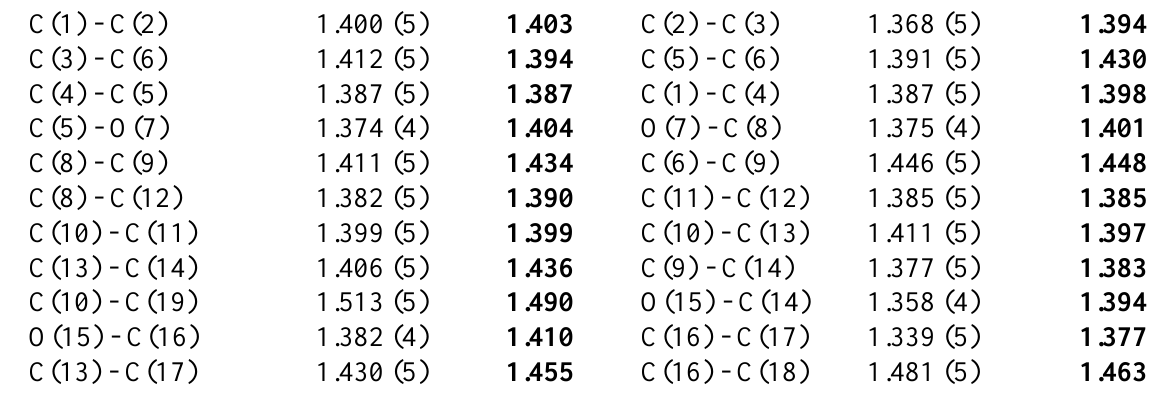
Table 8. Bond lengths (A) for compound B from X-ray and AM1